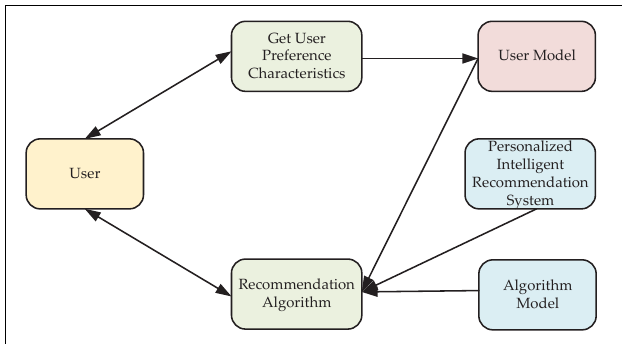
FIGURE 1 | Personalized IRS model.